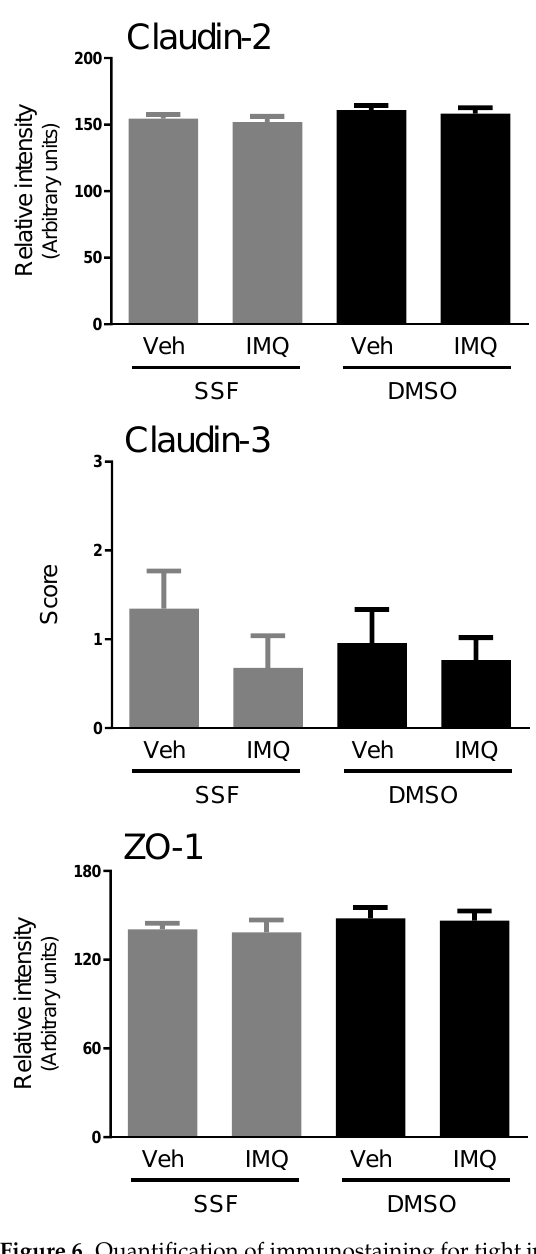
Figure 6. Quantification of immunostaining for tight junction-related proteins (claudin-2, claudin-3 and ZO-1) in control and imiquimod-treated rats with or without DMSO. See the Materials and Methods section for details of quantification. Data are the mean ± SEM, n = 3–5 per group. Veh: Vehicle. SSF: Saline. DMSO: Dimethyl sulfoxide.